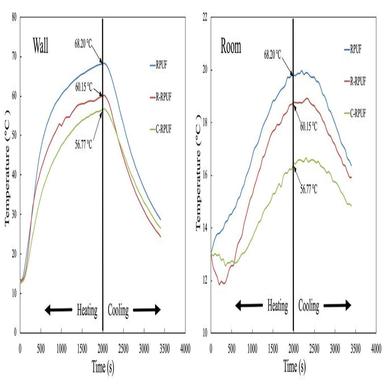
Curves of wall temperature and room temperature.